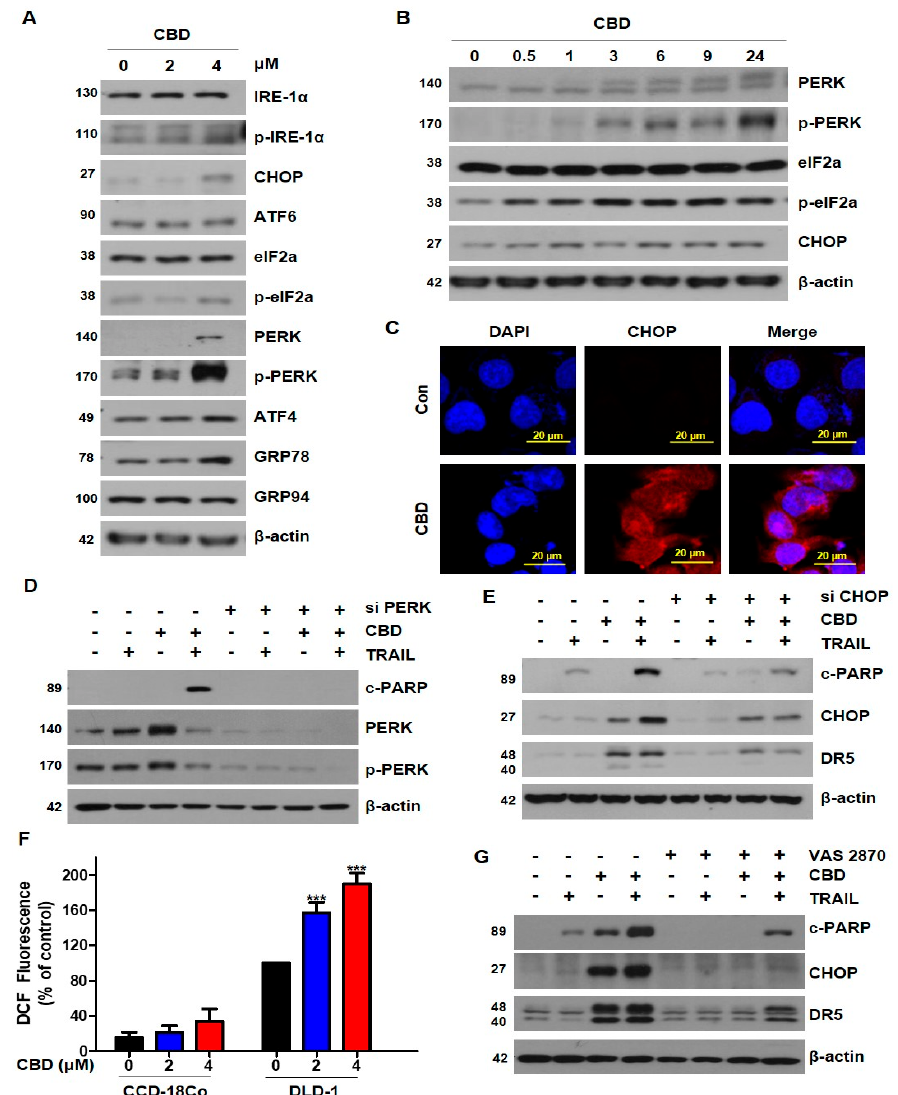
Figure 4. Cannabidiol induces ER stress in DLD-1 cells. ( A ) DLD-1 cells were treated with the indicated concentrations of cannabidiol for 24 h and expression levels of ER stress markers were analyzed by western blot. β -actin was used as a loading control. ( B ) Cells were treated with 4 μ M cannabidiol for the indicated times. ER stress-related protein expression levels were determined by western blot. ( C ) Immunofluorescence of CHOP ( red ) and nucleus ( blue ) in DLD-1 cells exposed to cannabidiol (4 μ M) for 24 h by confocal microscopy. ( D ) DLD-1 cells were transiently transfected with